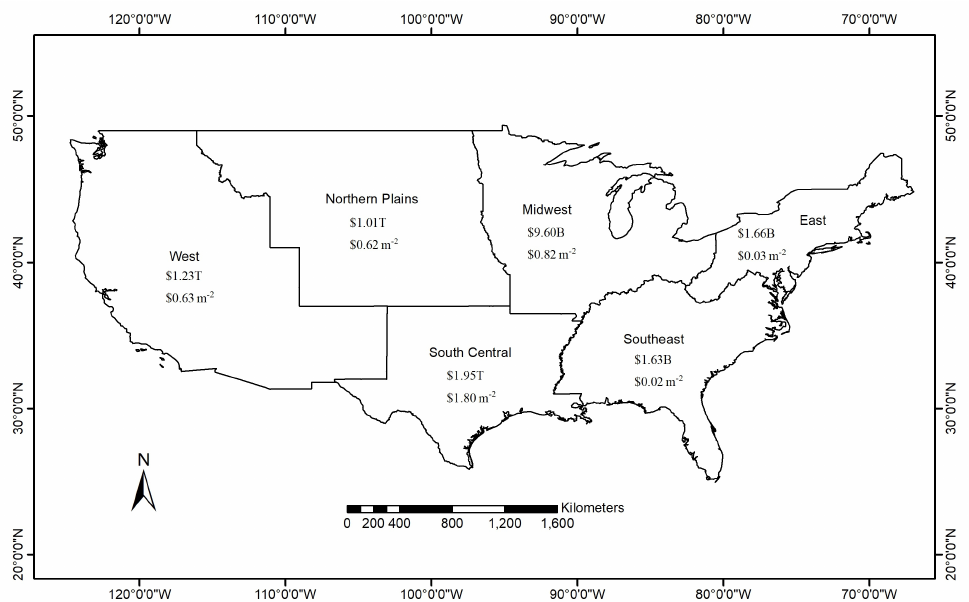
Figure 3. The midpoint replacement cost value of SIC for total storage (top number) and value normalized by area (bottom number) for different regions in the contiguous United States based on [9] and a 2014 average price for limestone of $10.42 per U.S. ton Figure 3. Vertical displacement analysis. ( a ) Vertical displacement map of Figure 2c with superimposed the black lines representing the main structural alignments located in this area. Moreover, the black lines represent the traces of the displacement profiles reported in panels ( b – e ), in which the subsided and the uplifted volumes are highlighted in red and light blue, respectively.